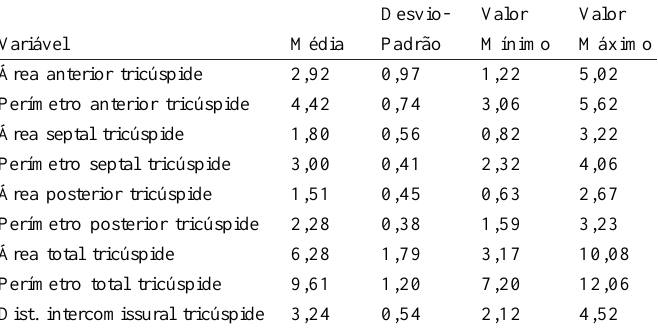
Tabela 2. Estatísticas das variáveis obtidas da valva